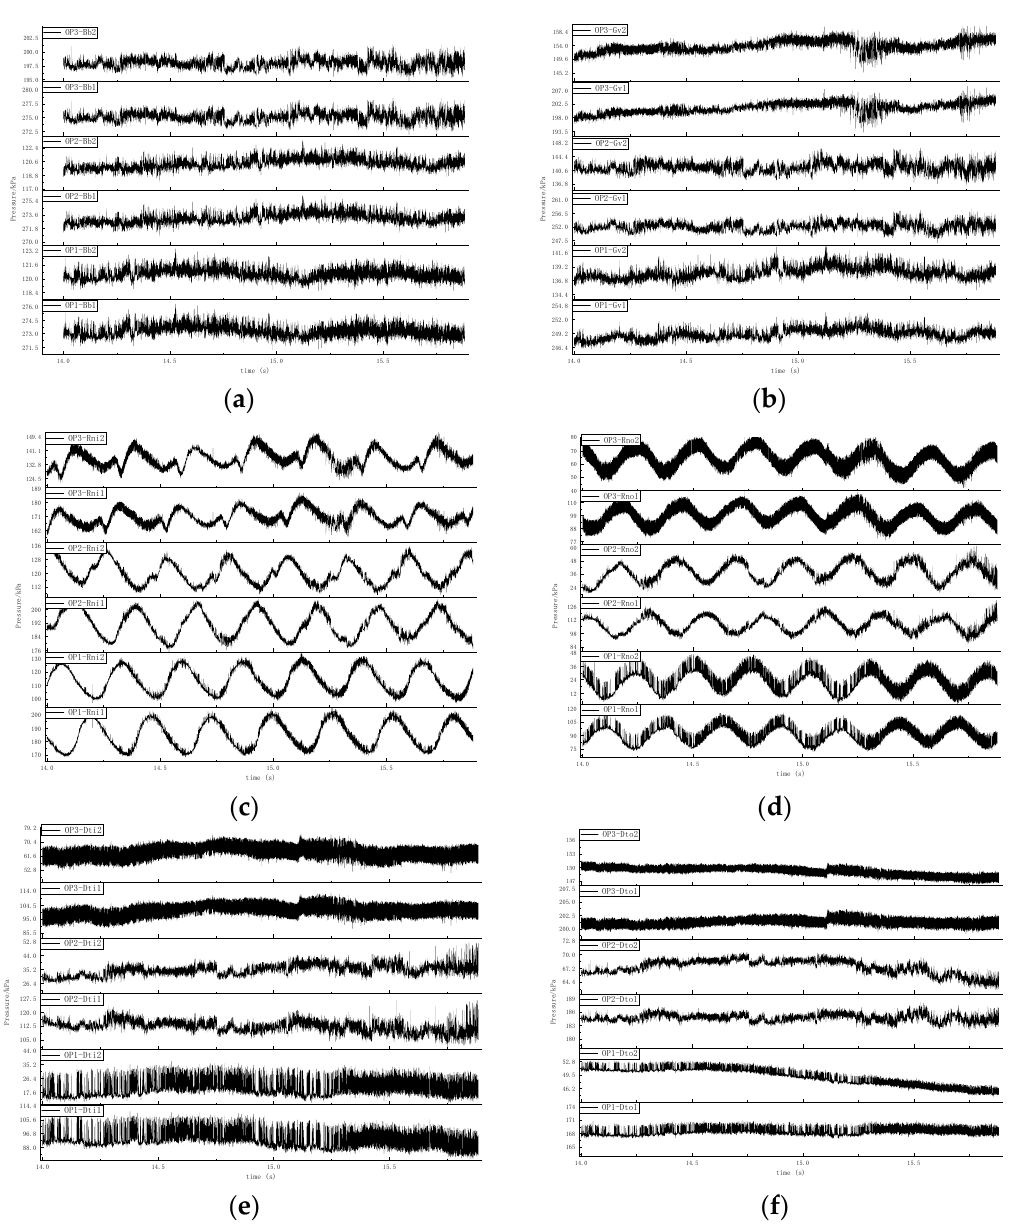
Figure 10. Pressure fluctuation distribution under different conditions: ( a ) Bulb type; ( b ) guide vane; ( c ) runner inlet; ( d ) runner outlet; ( e ) draft tube inlet; ( f ) draft tube outlet. The fast Fourier transform is used to obtain the pressure fluctuation frequency spec- trum characteristics at different monitoring points, as shown in Figure 11. This process is performed to further study the pressure fluctuation frequency characteristics of the turbine flow components under the influence of the free surface and water gravity. The pressure fluctuation frequency in the horizontal tubular turbine is mainly the blade passing frequency of 0.3 fn, rotating frequency fn, and blade passing frequencies of 3 fn, 6 fn, and 9 fn. The distribution of the internal spectrum characteristics of the unit is the same under different conditions. In order to clearly reflect the contribution of pressure pulsation with different frequencies to the vibration of the hydraulic turbine, the pressure pulsation amplitudes with three typical frequencies of 0.3 fn, fn and 3 fn are given in Figure